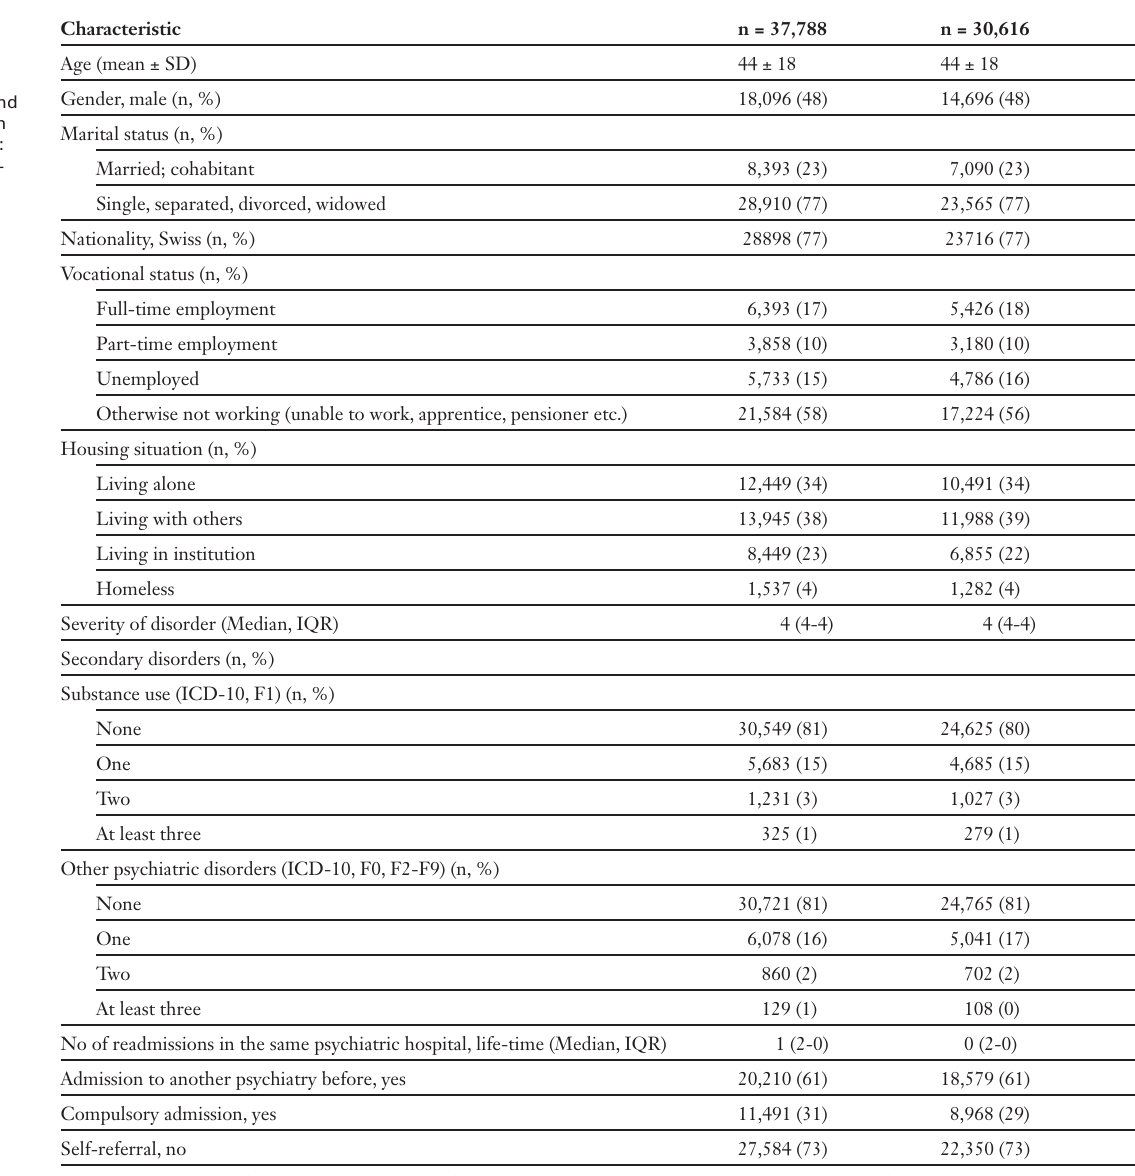
Comparison of patients meeting inclusion criteria and patients included in statistical analyses: sample characteris- tics.